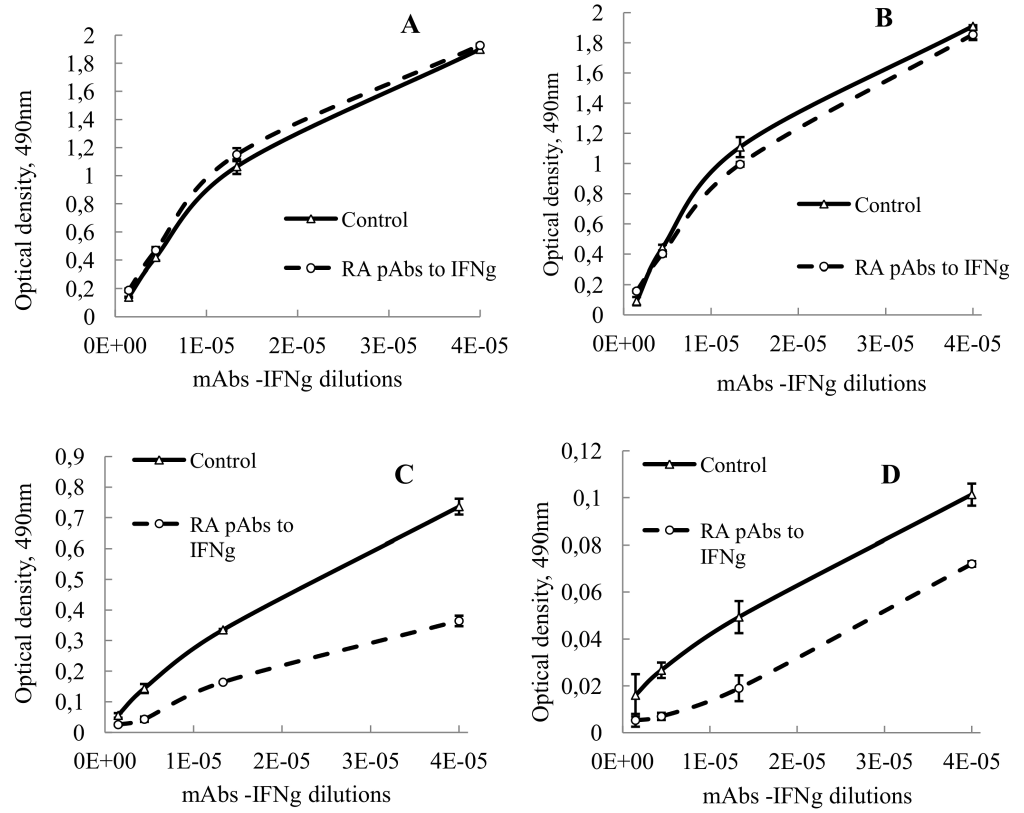
Figure 2. The influence of absorbed IFN-gamma concentration on detection of RA forms of anti-IFN-gamma antibodies. The figure shows the influence of the concentration of IFN-gamma adsorbed onto microtiter plates on the mAbs dilution curves observed in the presence of control or RA-antibodies to IFN-gamma (RA Abs to IFNg). Test samples prepared of mAbs, pre-diluted up to 1:5000–1:135000 in TBS, and either RA forms of Abs to IFN-gamma (RA Abs to IFNg) or control, mixed at a ratio 1:4 v/v respectively. 100 m L of each sample was transferred into the wells (3 wells for each sample) and was incubated for 45 minutes at room temperature while shaking (shaker-incubator Dynatech, USA). The remainder of the experiment was conducted in accordance with the standard ELISA protocol. Dilutions of mAbs on X axis are those observed after mixing with RA forms of Abs to IFN-gamma or control (where 0.00001 means dilution of starting antibodies to 1:100000 times, 0.00002 or 2E-05 means dilution of starting antibodies to 1:50000 times etc.). The Y-axis displays 490 nm optical densities. The error bars represent the standard deviations of the measurements. The concentrations of IFN-gamma adsorbed on the plate are: A 6 m g/ml B - 2 m g/ml C - 0.7 m g/ml; D - 0.25 m g/ml. RA samples are significantly different from the control (F31/60=93.4; p , 0.0001) in the case of the C and D